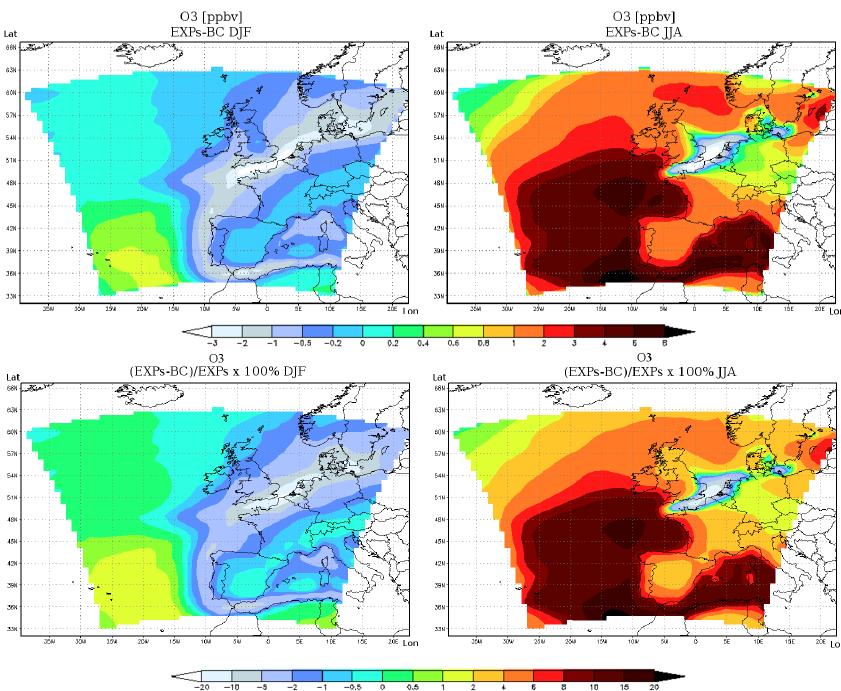
Fig. 4. Upper row: average absolute O 3 surface perturbation introducing ship emissions for winter (upper left) and summer (upper right) season as difference of experiments EXPs and BC. Lower row: average relative contribution of ship induced O 3 to the total for winter (left) and summer (right) season as (EXPs-BC)/EXPs × 100%. Negative values indicate the fraction of the destroyed ozone to the total ozone simulated with ship traffic.